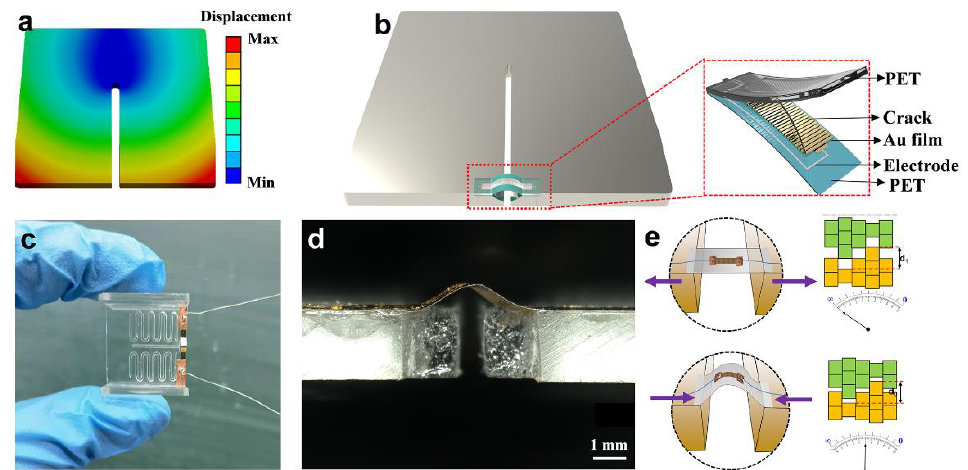
Figure 1. The bio-inspired coupling design of slit-based mechano-sensor composed of FUCMSS and substrate with controlled slit. ( a ) Finite-element simulation analysis of the substrate with controllable slit. ( b ) The schematic of the slit-based mechano-sensor. ( c ) The manufactured slit-based sensor sample. ( d ) The bending deformation of FUCMSS covering slit wake. ( e ) The connection–disconnection process of nanoscale cracks with the bending deformation of the FUCMSS.